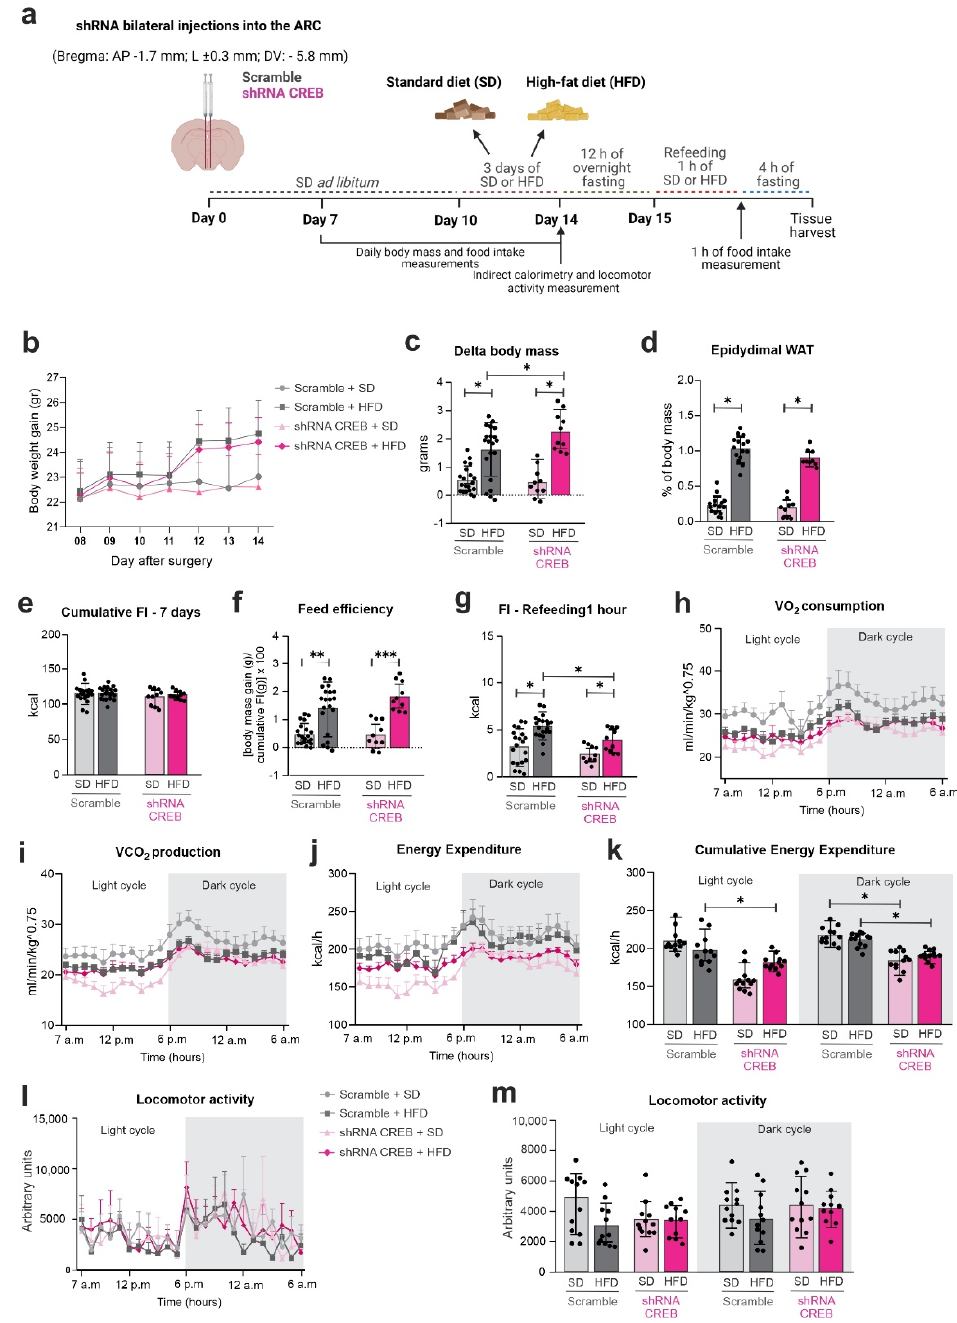
Figure 6. Hypothalamic CREB down-regulation changes metabolic parameters upon short-term HFD . Adult male C57BL/6J mice were submitted to a bilateral injection of lentivirus particles (Scramble or shRNA CREB) into the arcuate nucleus (ARC) and, after 10 days, were fed an SD or HFD for 3 days. Hypothalamus and blood were collected at day 15 after surgery. ( a ) Schematic representation of experimental protocol; ( b ) body-mass gain; ( c ) delta body mass; ( d ) epididymal fat depot; ( e ) cumulative food intake; ( f ) food intake over an hour after a 12 h fasting; ( g ) feed efficiency; ( h ) oxygen (O 2 ) consumption; ( i ) carbon dioxide (CO 2 ) production; ( j ) energy expenditure; ( k ) cumulative energy expenditure; and ( l , m ) total locomotor activity in metabolic cage during light and dark cycles on day 10 post-surgery. Data are presented as means ± SD. N = 15–20 mice in two different cohorts. Two-way ANOVA followed by Sidak’s post hoc test was used for statistical analyses. * p ≤ 0.05, ** p < 0.01 and *** p < 0.001 in comparison with groups indicated in the figure.